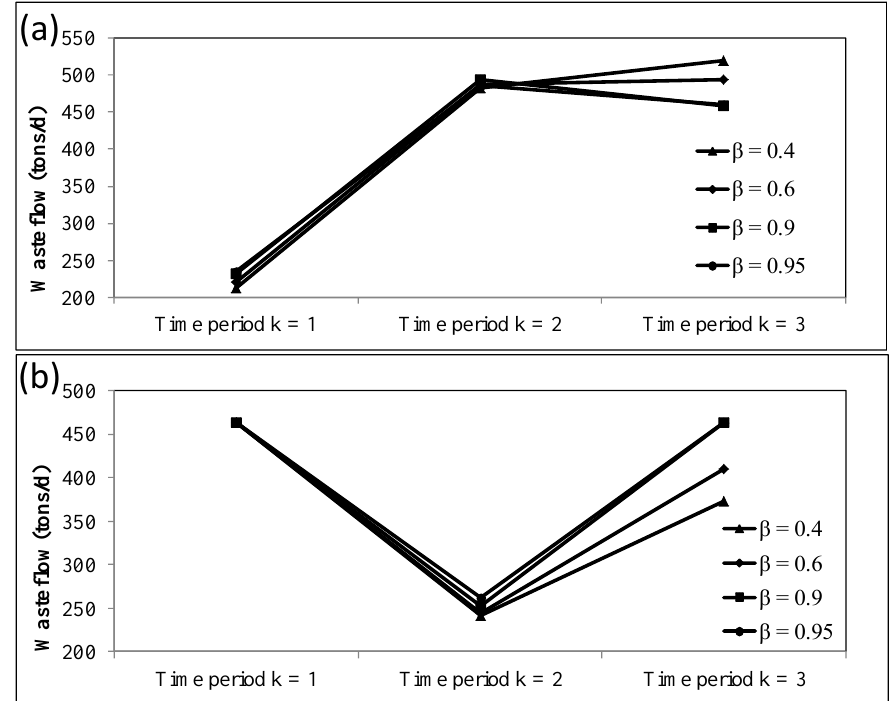
ff erent β levels when ω